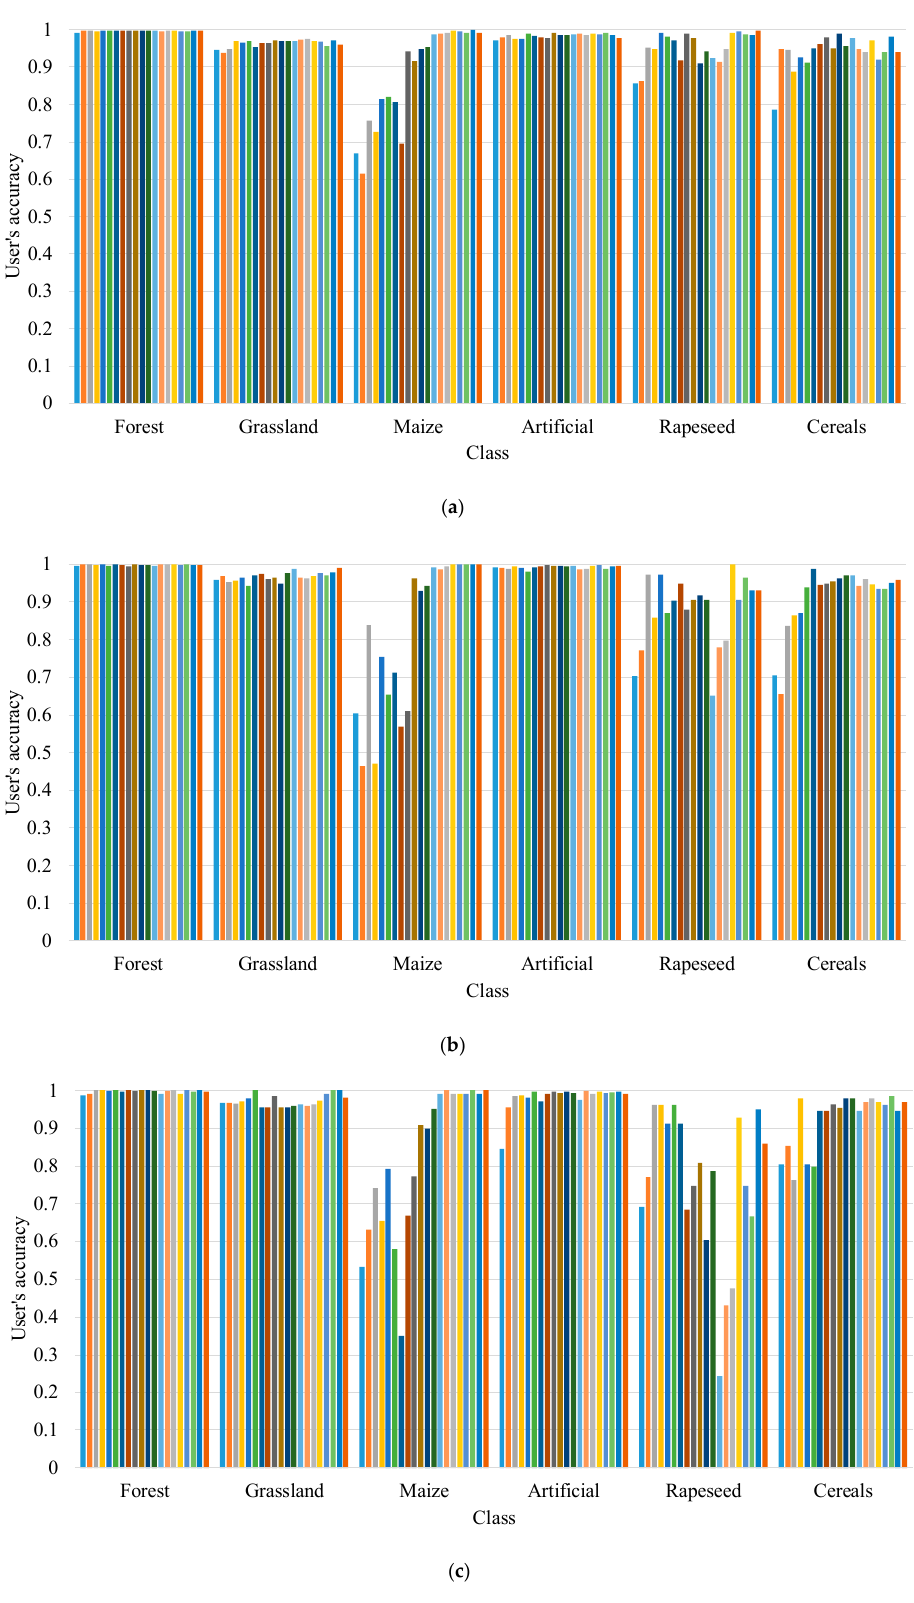
Figure 6. The user’s accuracy (UA) of each class with an increasing number of images used at different segmentation scales for Study Area 1. ( a ) Scale 50, ( b ) scale 100, and ( c ) scale 150. The colored bars from left to right represent the number of images from 1 to 20.